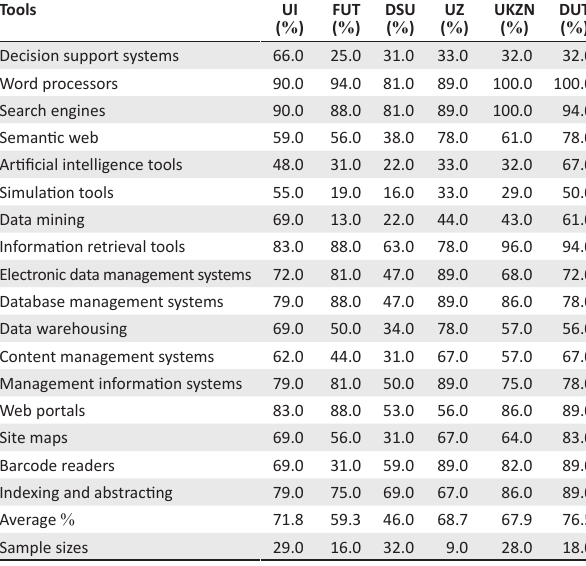
TABLE 2: Tools for knowledge management practices in academic libraries. Tools